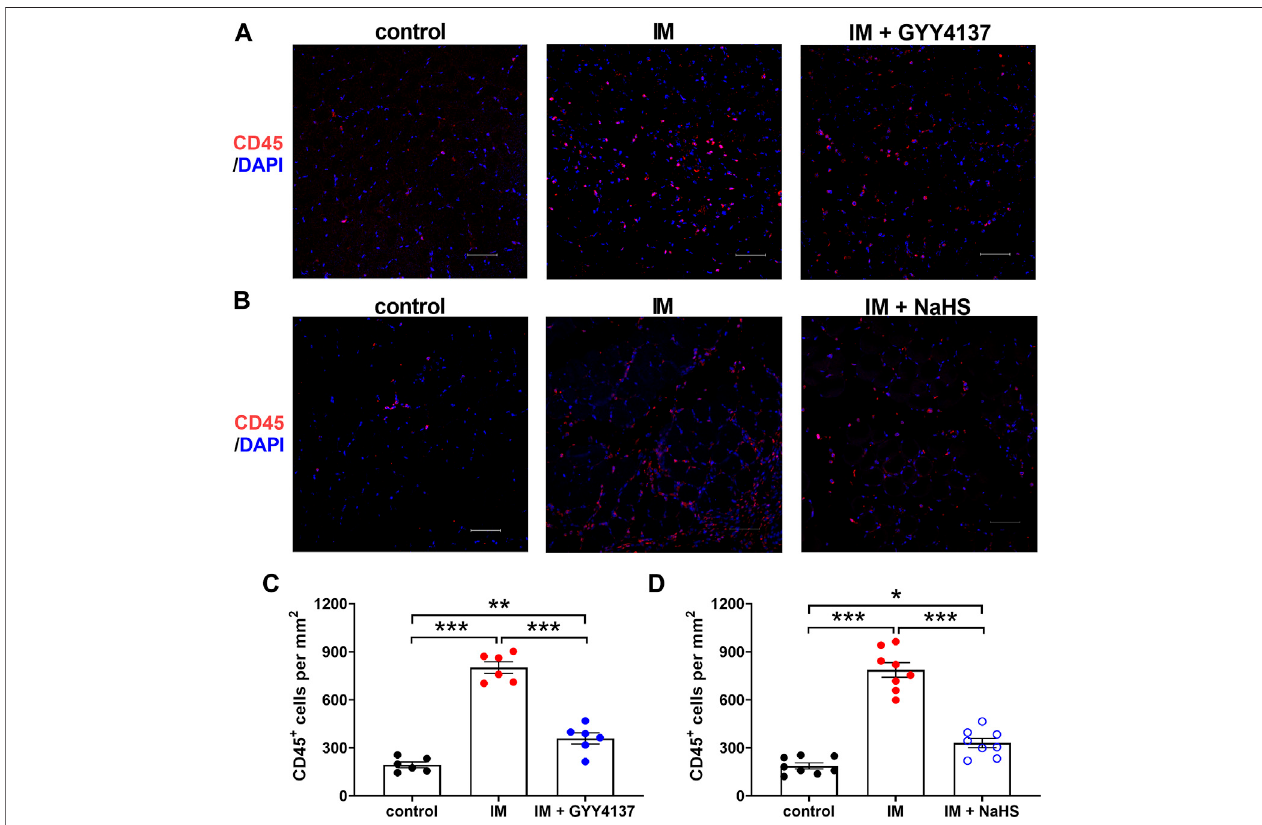
FIGURE5| H2SdonorsalleviatetheIM-inducedleukocytein fi ltrationinskeletalmuscles.MiceweresubjectedtoIMandtreatedwithGYY4137(aandc,50 μ g/kg/ d, ip), or NaHS (b and d, 1.12 mg/kg, twice a day, ip) for 2 weeks. The control and IM groups received identical doses of saline for 2 weeks. (A) and (B) , Representative micrographs of CD45 + leukocyte staining in TA muscles (Scale bar, 50 μ m). (C) , Quantitative analysis of CD45 positive staining leukocytes of TA muscles in control, IM, andIM+GYY4137mice(n=6ineachgroup). (D) ,QuantitativeanalysisofCD45positivestainingleukocytesofTAmusclesincontrol,IM,andIM+NaHSmice(n= 8 in each group). Data represent means ± SEM. * p < 0.05, ** p < 0.01, *** p <